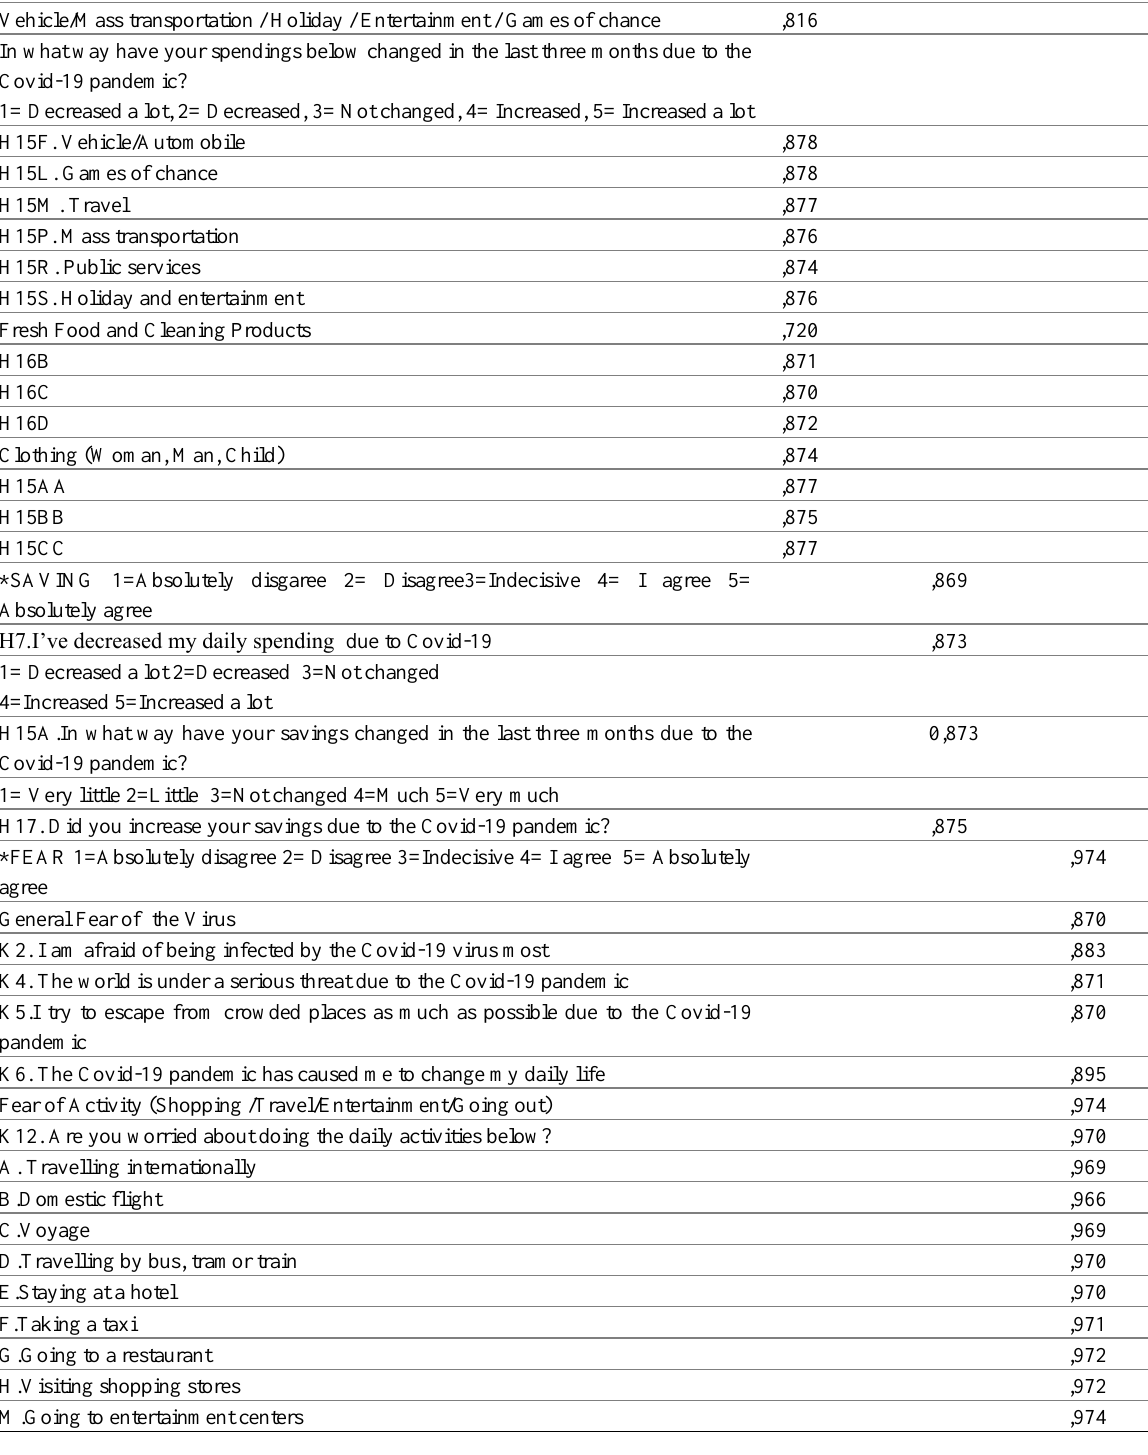
Cron. Alph Cron. ,869 Alph ,974